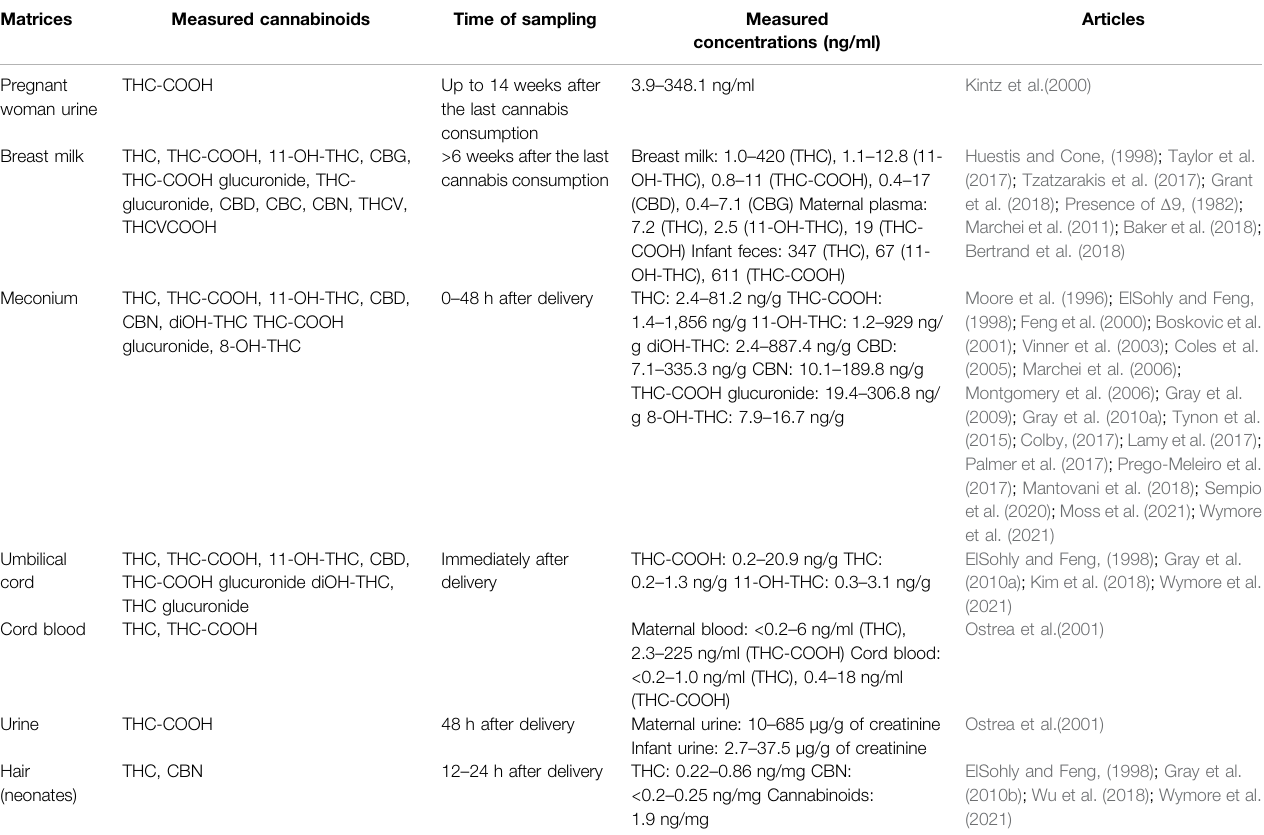
TABLE 2 | Pharmacokinetics of cannabinoids in pregnant and lactating women and neonates.